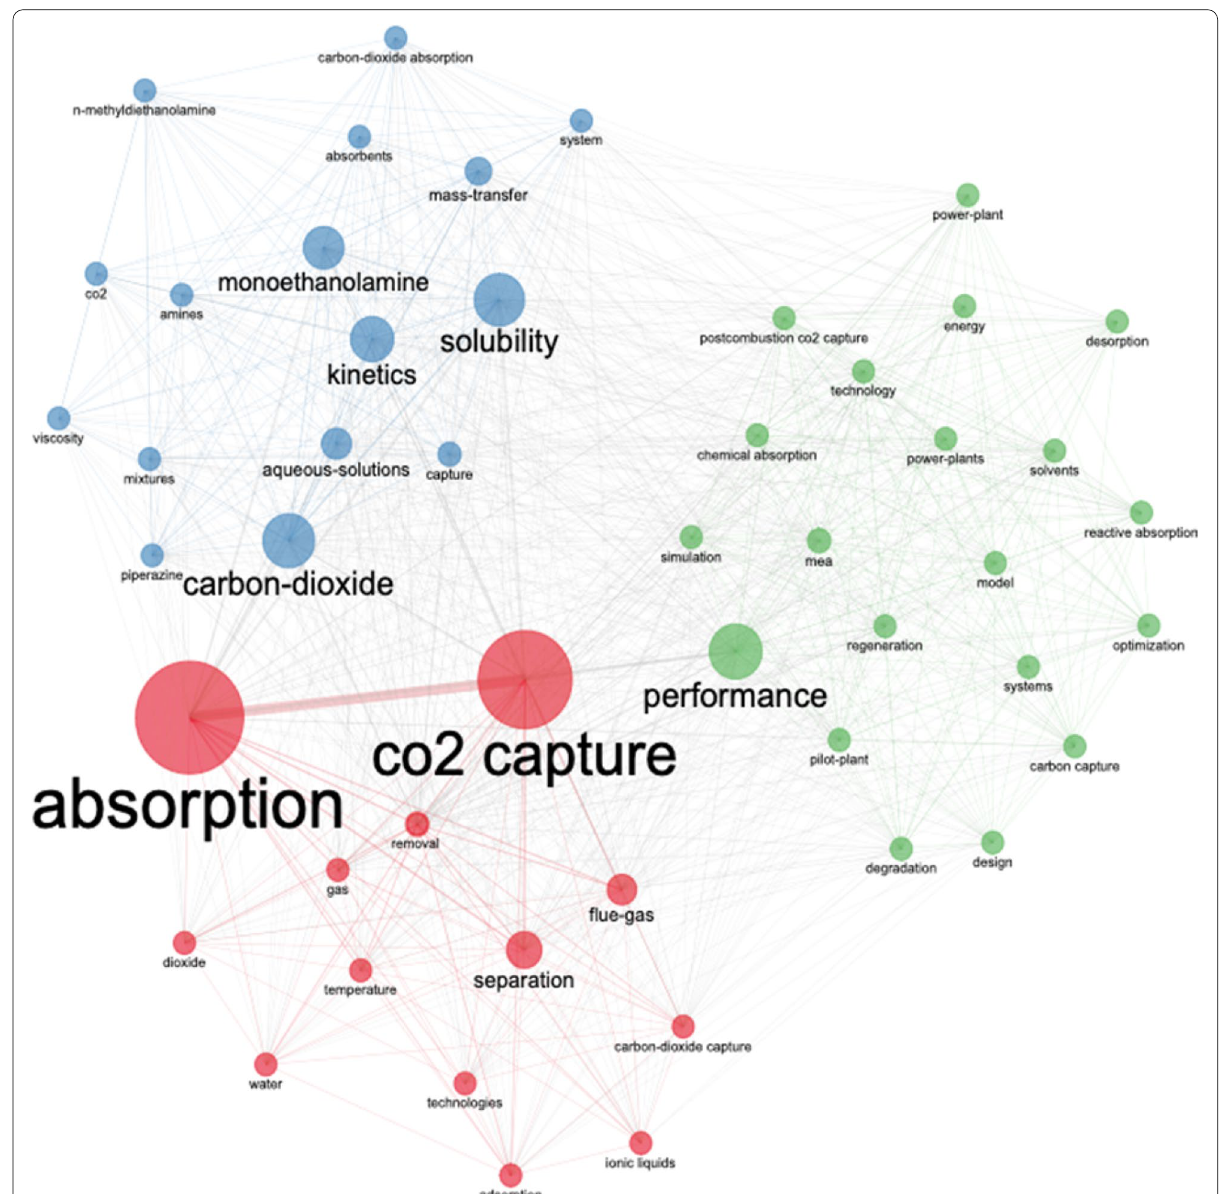
Fig. 51 Absorbent, keyword